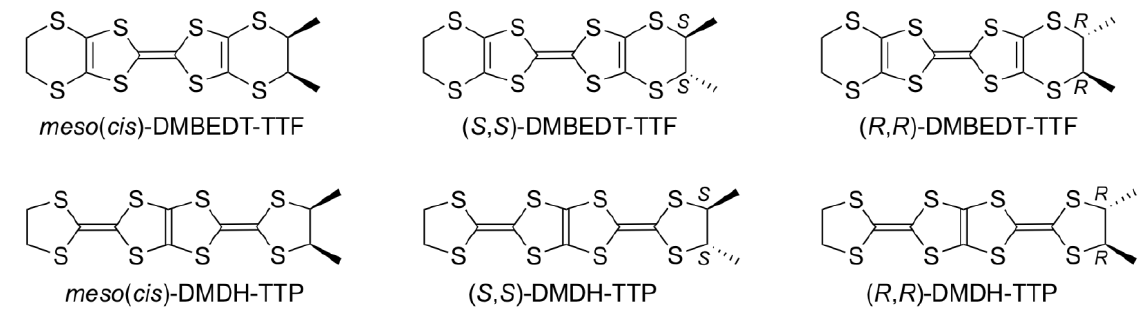
Figure 25. Stereoisomers of 1,2-dimethylethylenedithio(ethylenedithio)tetrathiafulvalene (DMBEDT-TTF) and 2-(4,5-dimethyl-1,3-dithiolan-2-ylidene)-5-(1,3-dithiolan-2-ylidene)- 1,3,4,6-tetrathiapentalene